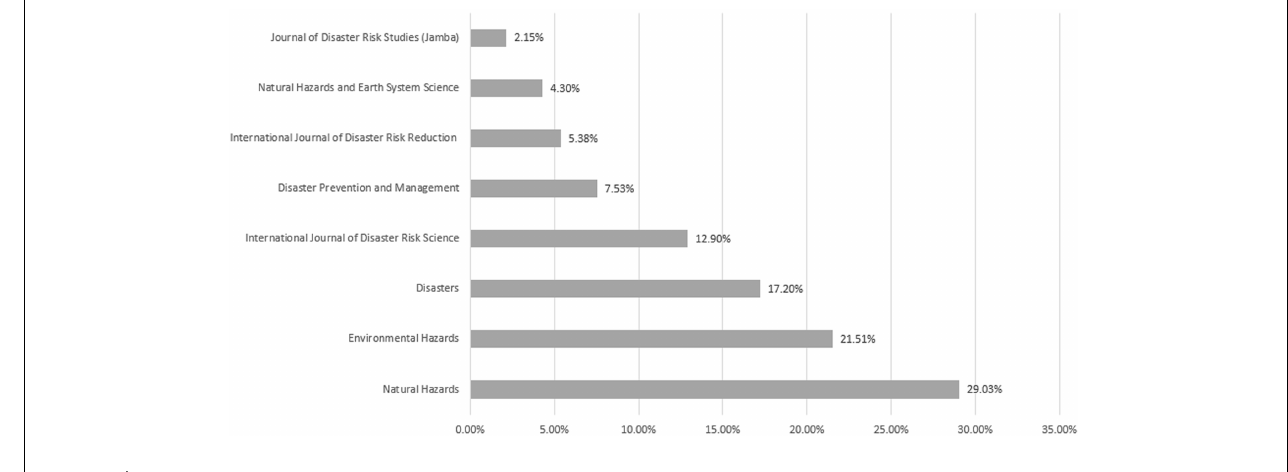
FIGURE 3 | Percentage of selected studies per source.